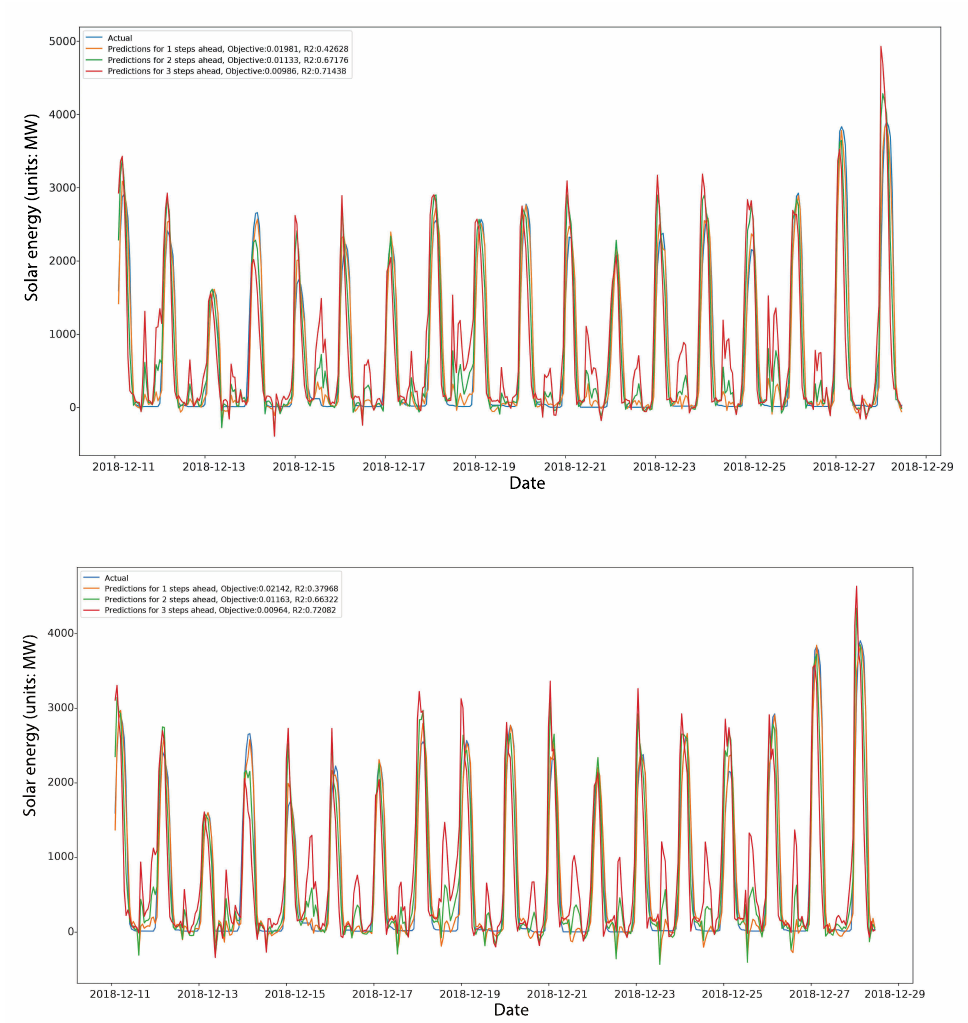
Figure 7. Graphical representation of the best predictions of the proposed LSTM-HRSA ( top ), compared to the best predictions of the elementary LSTM-RSA method ( bottom